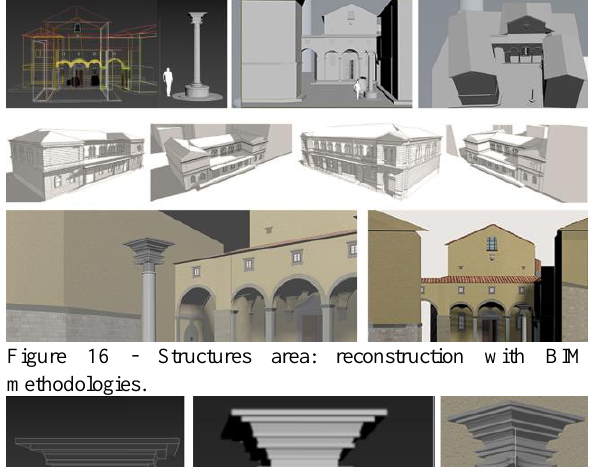
Figure 15 - Analysis lexicon “De-morphogenesis”: horizontal and vertical structures.